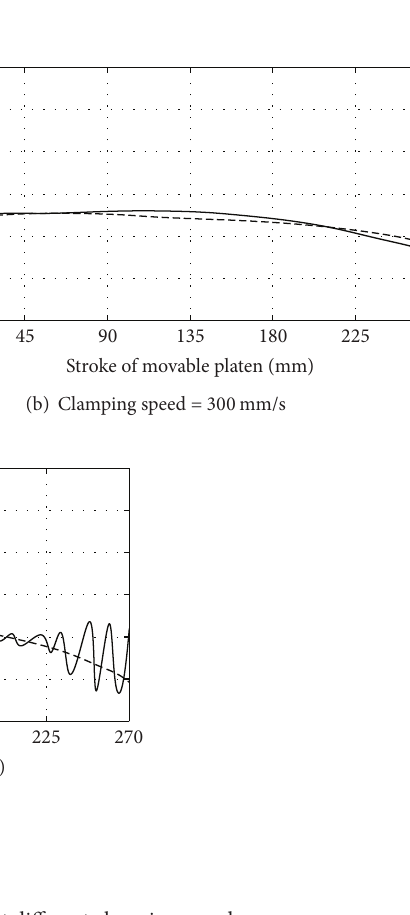
Figure 8: Vibrating displacement of D point in 𝑋 direction at different clamping